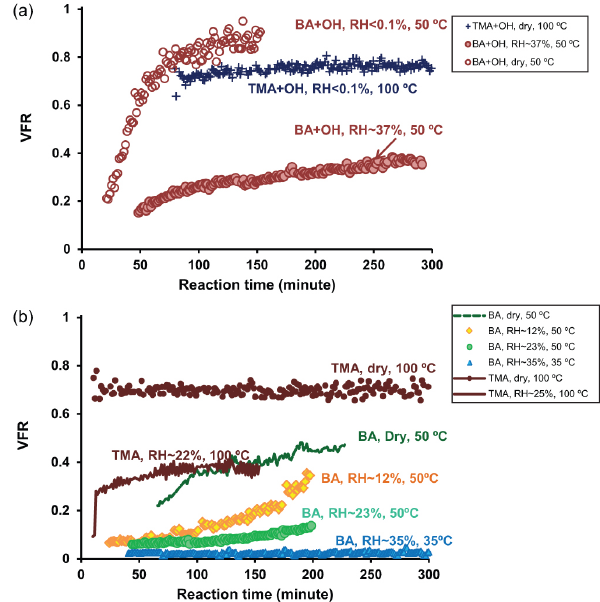
Figure 1. Volume fraction remaining (VFR) of secondary aerosol formed from (a) OH photooxidation and (b) amine–N 2 O 5 reac- tions. For TMA aerosols, VTDMA temperature was set to be 100 ◦ C, while for BA 50 ◦ C or 35 ◦ C because of their higher volatil-